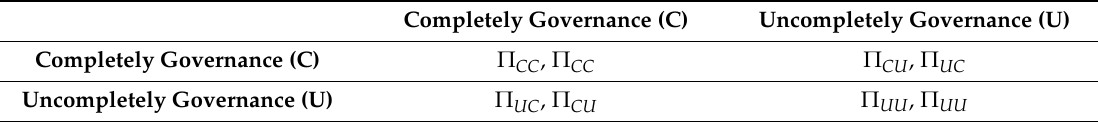
Table 1. Payo ff matrix of the game in environmental governance